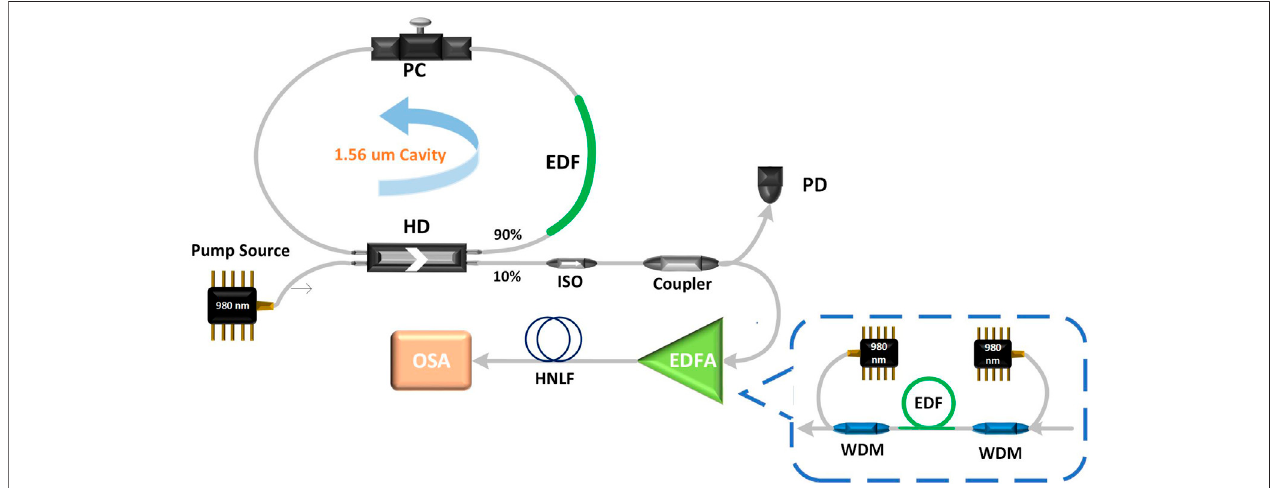
FIGURE 1 | Experimental schematic of the SC generation using a passively mode-locked femtosecond EDFL. The dispersion compensation fi bers are not depicted.HD:hybriddevice,comprisingawavelength-divisionmultiplexing(WDM)coupler,atapcoupler,andapolarization-sensitiveisolator,EDF:erbium-doped fi